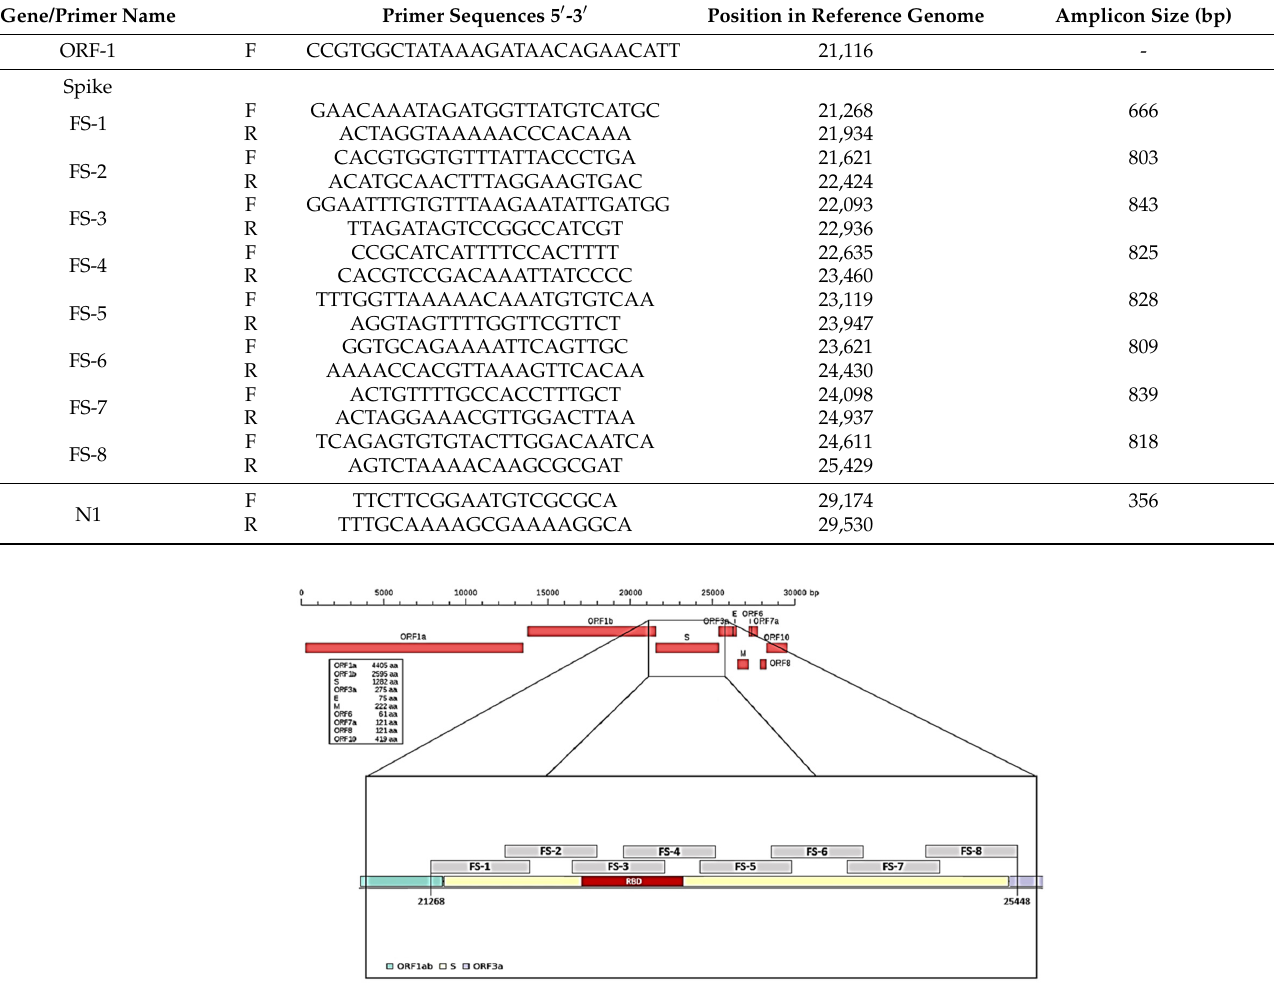
Table 1. Oligonucleotide sequence for spike gene fragments (FS) and N gene. F, forward primers; R, reverse primers.